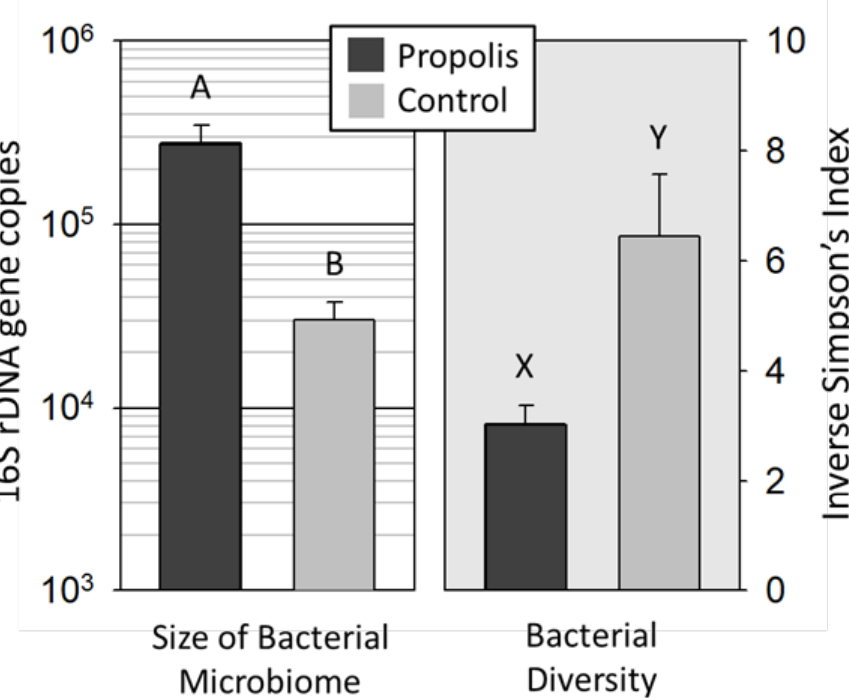
Figure 1. Propolis treatment increased the bacterial abundance but reduced the bacterial diversity. The total bacterial 16S rRNA gene copy number was significantly greater on mouthparts of worker bees in colonies with (A) a propolis envelope compared to the mouthparts of worker bees in colonies without (B) a propolis envelope. Whiskers depict the standard error of the mean. The Inverse Simpson’s Index was significantly lower on the mouthparts of worker bees in colonies with a propolis envelope (X) compared to the mouthparts of worker bees in colonies without a propolis envelope (Y).